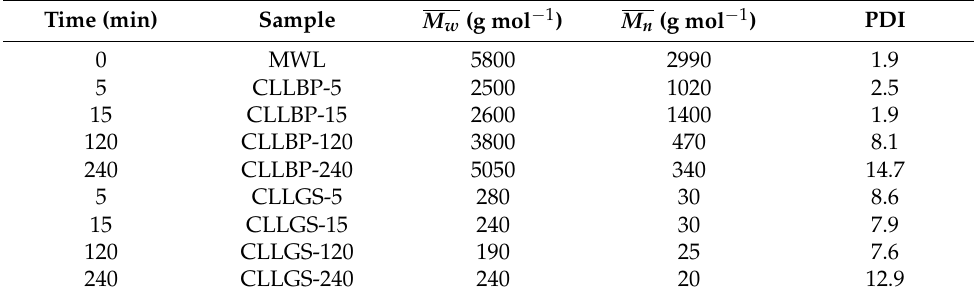
Figure 5. SEC chromatograms of MWL (used as a reference), CL LBP -5, CL LBP -120 and CL LBP -240 samples ( I ); CL LGS -5, CL LGS -120 and CL LGS -240 samples ( II ); W LBP -15, W LBP -120 and W LBP -240 samples ( III ); and W LGS -15 and W LGS -240 samples ( IV ). Table 3. Weight-average molecular weight ( M w ), number-average molecular weight ( M n ) and polydispersity index (PDI) of the MWL (used as reference), CL LBP and CL LGS samples with time of